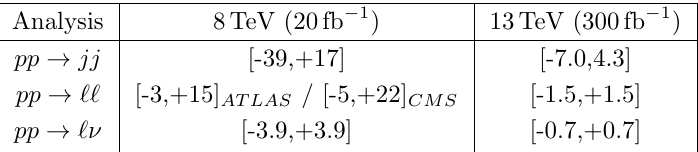
Table 6 . 95% CL projected bounds on the W parameter, extracted from the dijet invariant mass distribution at 8 and 13 TeV. We compare the dijet reach with the neutral and charged Drell-Yan bounds from ref. [28]. Note that the 8 TeV pp ! ‘‘ entry corresponds to the recasting of actual data from ATLAS and CMS [28], whereas the other 8 TeV bounds are